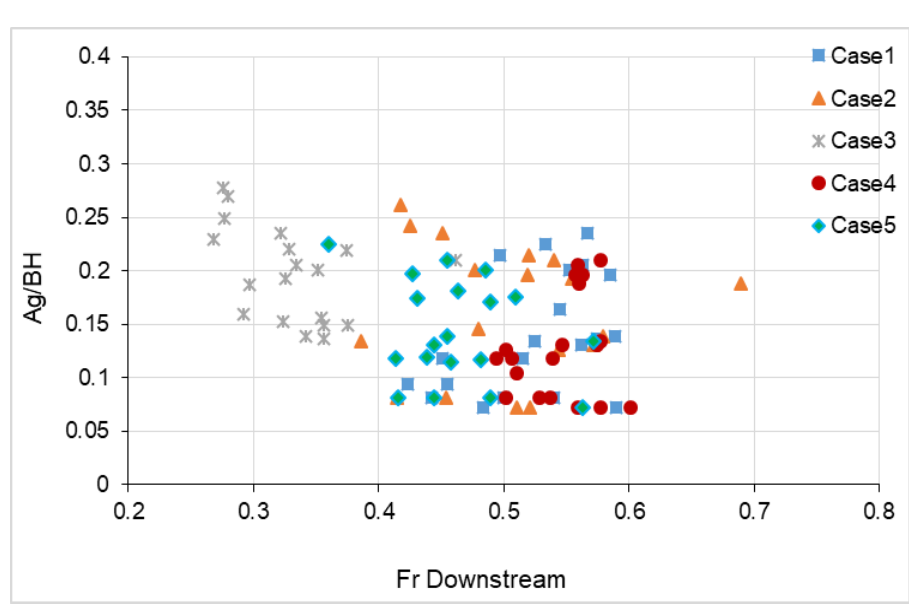
Figure 12. Relation between Ag⁄BH and downstream Froude